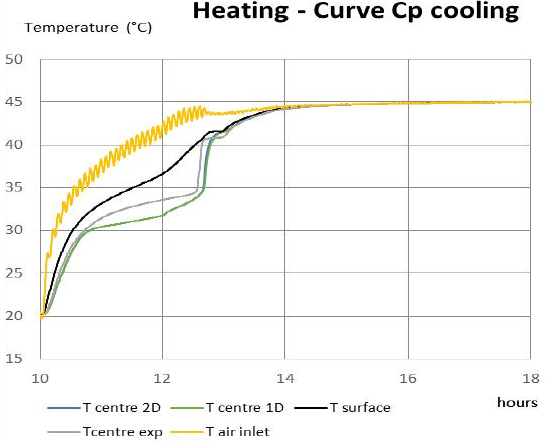
Figure 17. Temperature variation at the centre of the container. Cooling case with the cooling c p curve.